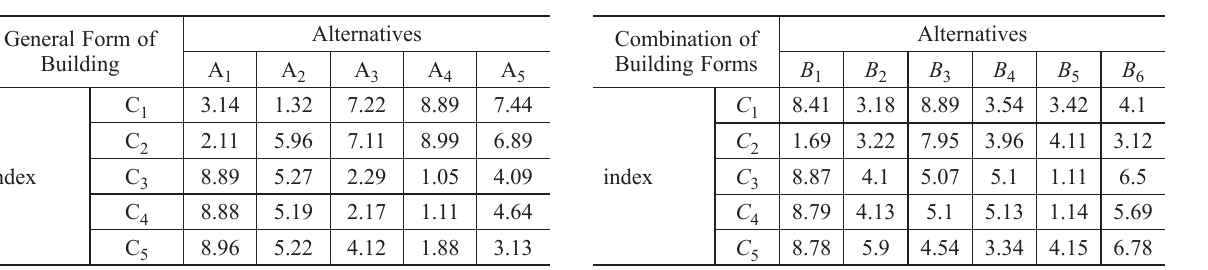
Table 10. Averages of experts’ scores for alternatives of overall forms of buildings as major index